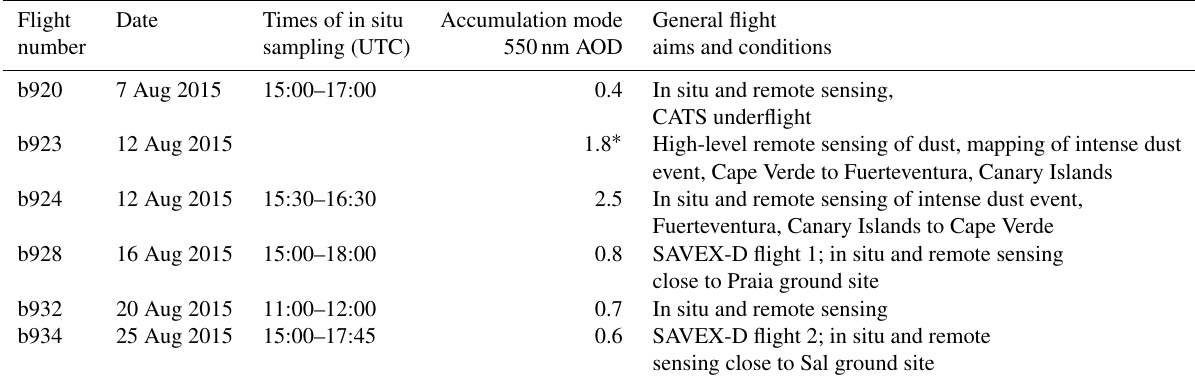
Table 2. Dates of AER-D flights and times of intensive in situ sampling SLRs and accumulation mode AOD at the region of in situ sampling.